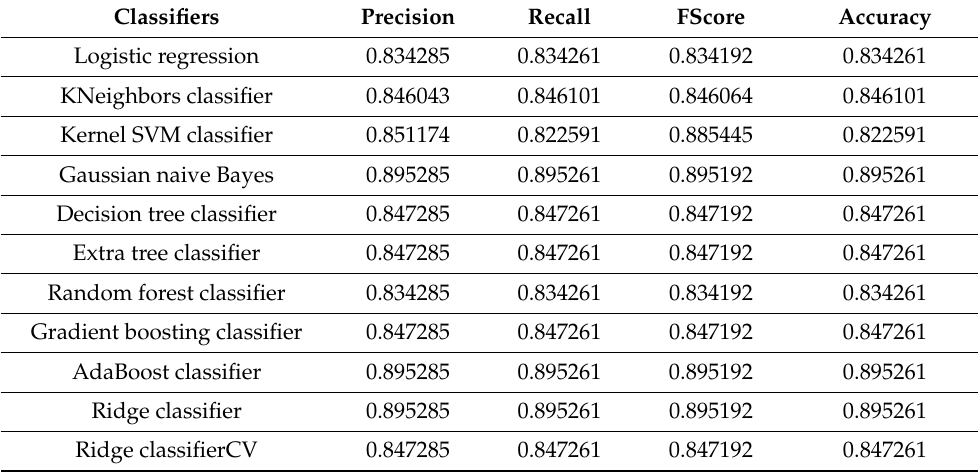
Table 13. Extra trees regressor metrics before feature